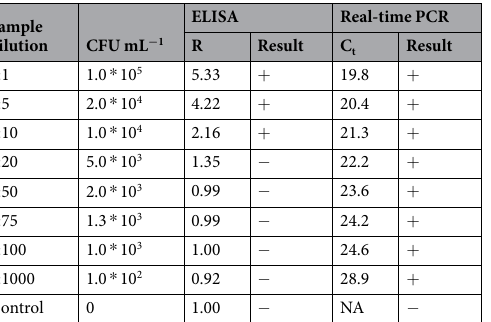
Table 1. Test results ( + = positive, − = negative) of samples ranging from 10 5 to 10 2 CFU mL − 1 , according to ELISA test or real-time PCR. R = OD-sample/OD-negative control; C t = cycle threshold. The reported values were obtained from the average of two technical replicates for each